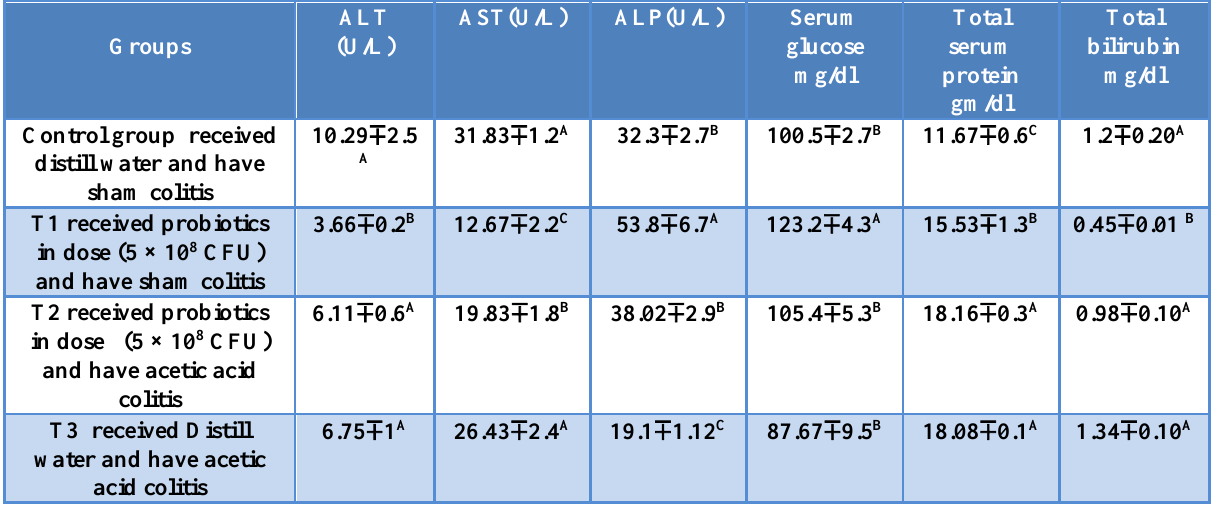
The capital letter denote significant differences between